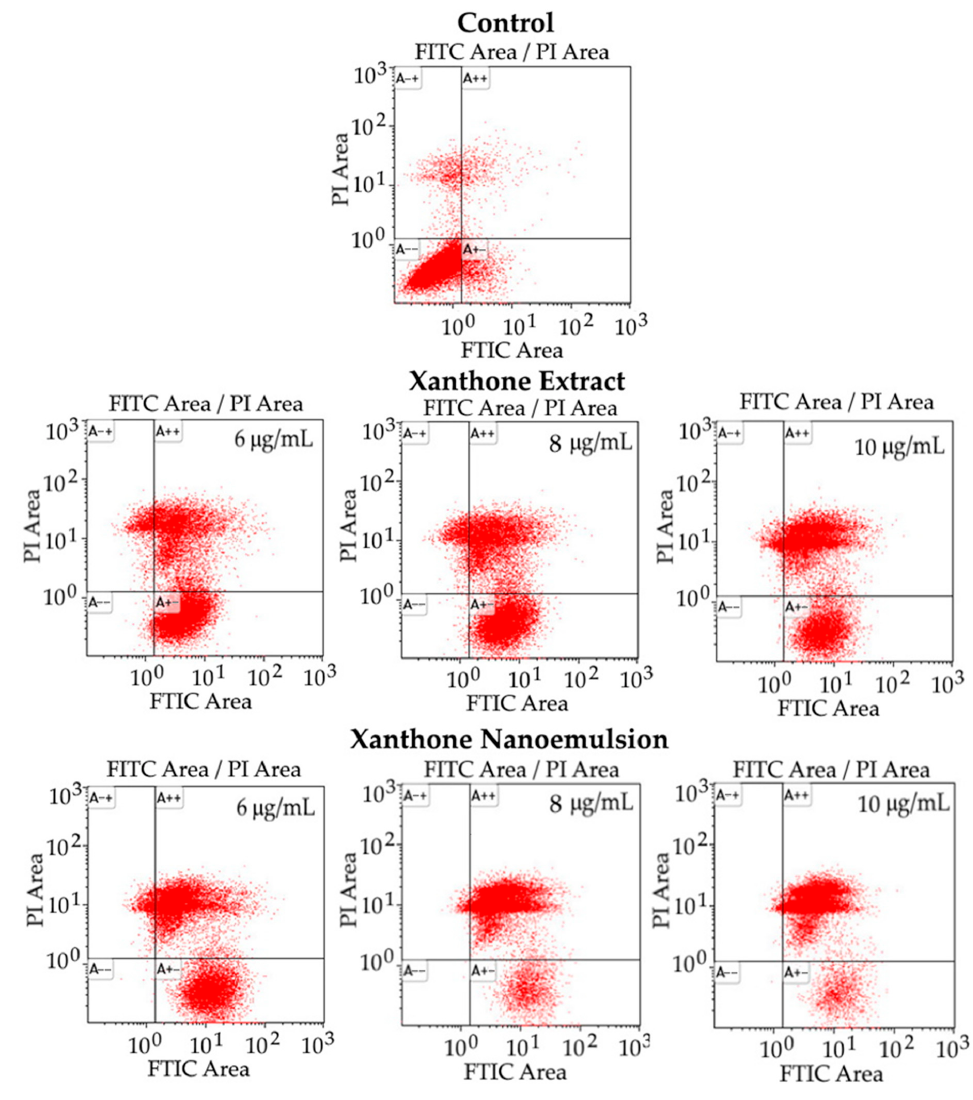
Figure 9. Apoptosis of liver cancer cells HepG2 treated with different concentrations of xanthone extract and xanthone nanoemulsion. Control: cells were incubated in medium only. A − +, necrosis